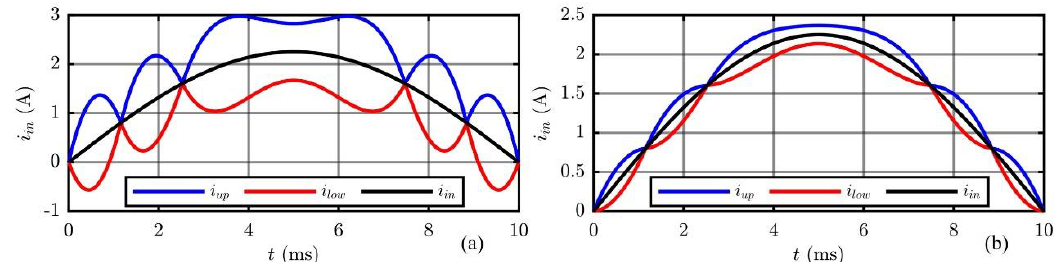
Figure 9. Input moving average current i in waveform was included within the peak ripple envelopes i up ( t ) and i low ( t ). ( a ) Current envelopes behavior with L eq = 100 μH, ( b ) current envelopes behavior with L eq = 500 μH.